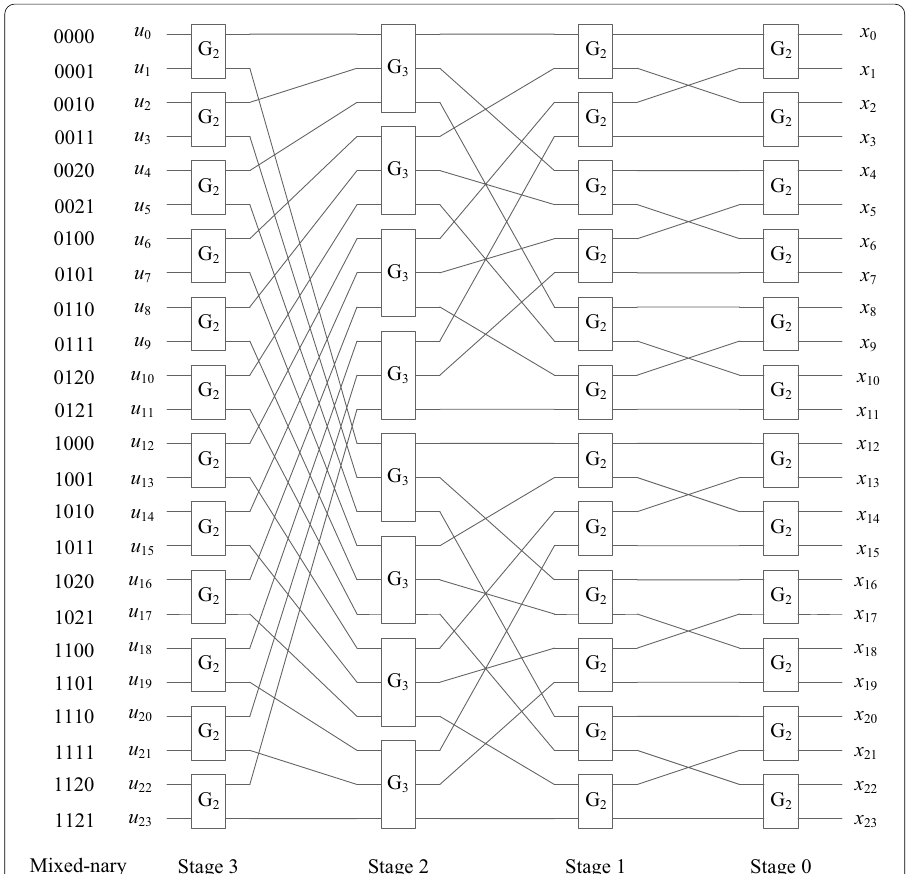
B 24 G ⊗ 2 2 G 3 G 2 , = · ⊗ ⊗